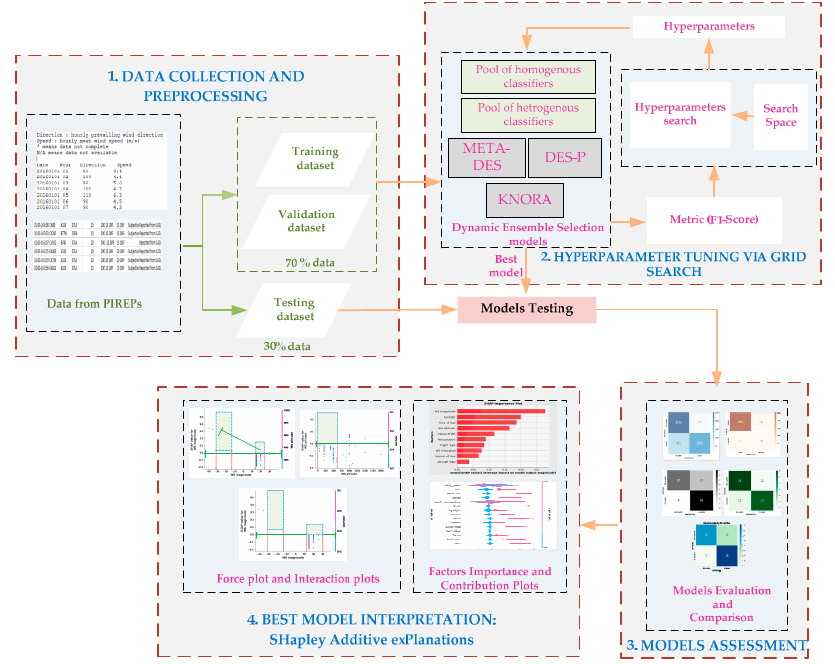
Figure 3. Proposed framework of our study.